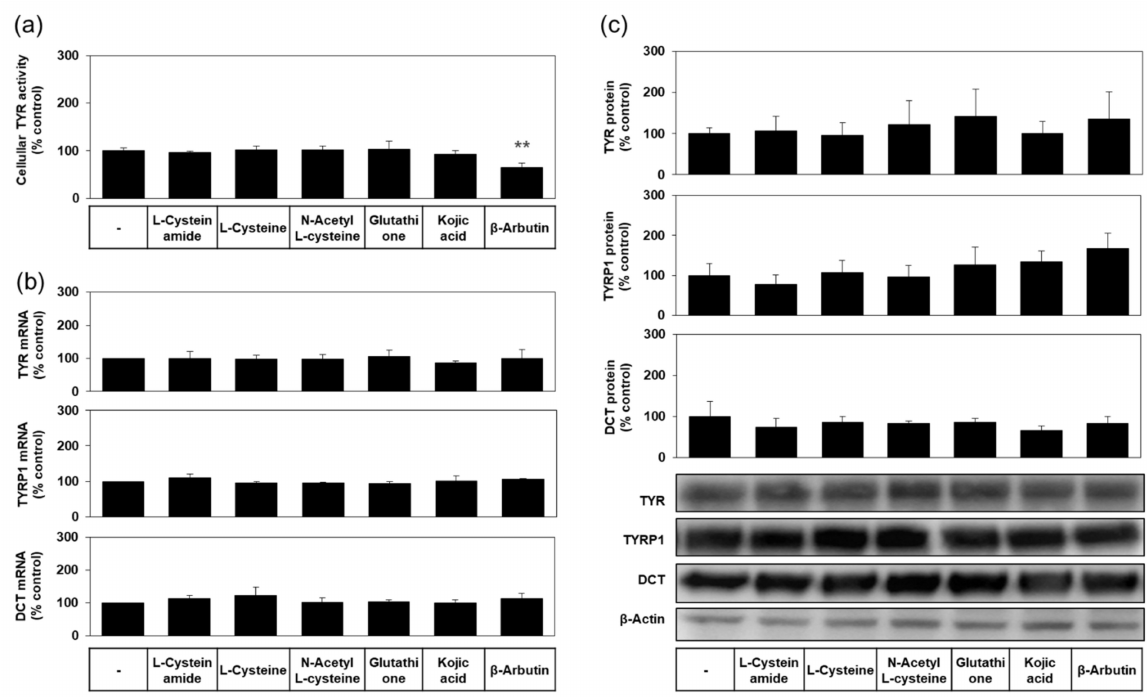
Figure 6. Effects of L-cysteinamide, L-cysteine, N-acetyl L-cysteine, glutathione, kojic acid, and β -arbutin on the activity levels of TYR, and the mRNA and protein expression levels of TYR, tyrosinase-related protein-1 (TYRP1), dopachrome tautomerase (DCT). MNT-1 cells were treated with vehicle (control) or each substance at 1.0 mM for 24 h. ( a ) TYR activity was determined using cell lysates ( n = 4). ( b ) The mRNA levels of TYR, TYRP1, and DCT were determined by qRT-PCR and normalized to glyceraldehyde 3-phosphate dehydrogenase (GAPDH) mRNA levels ( n = 3). ( c ) Their protein levels were quantified by Western blot and normalized to β -actin protein levels ( n = 4). Typical blot images are shown. Data are presented as % of control (means ± SD). ** p < 0.01 vs.